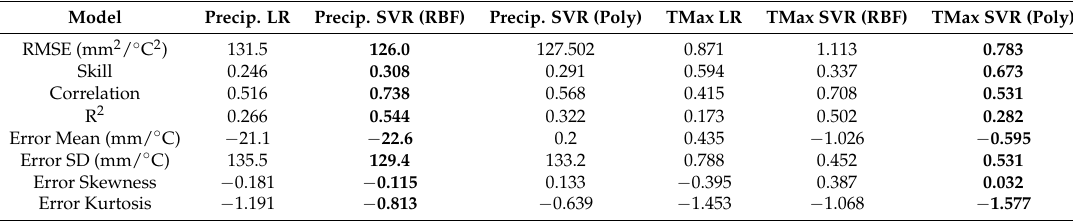
Table 4. Performance of each model on the testing data set (2006–2017). The best performing model for predicting annual precipitation and TMax is highlighted, based on low RMSE, and both high skill and